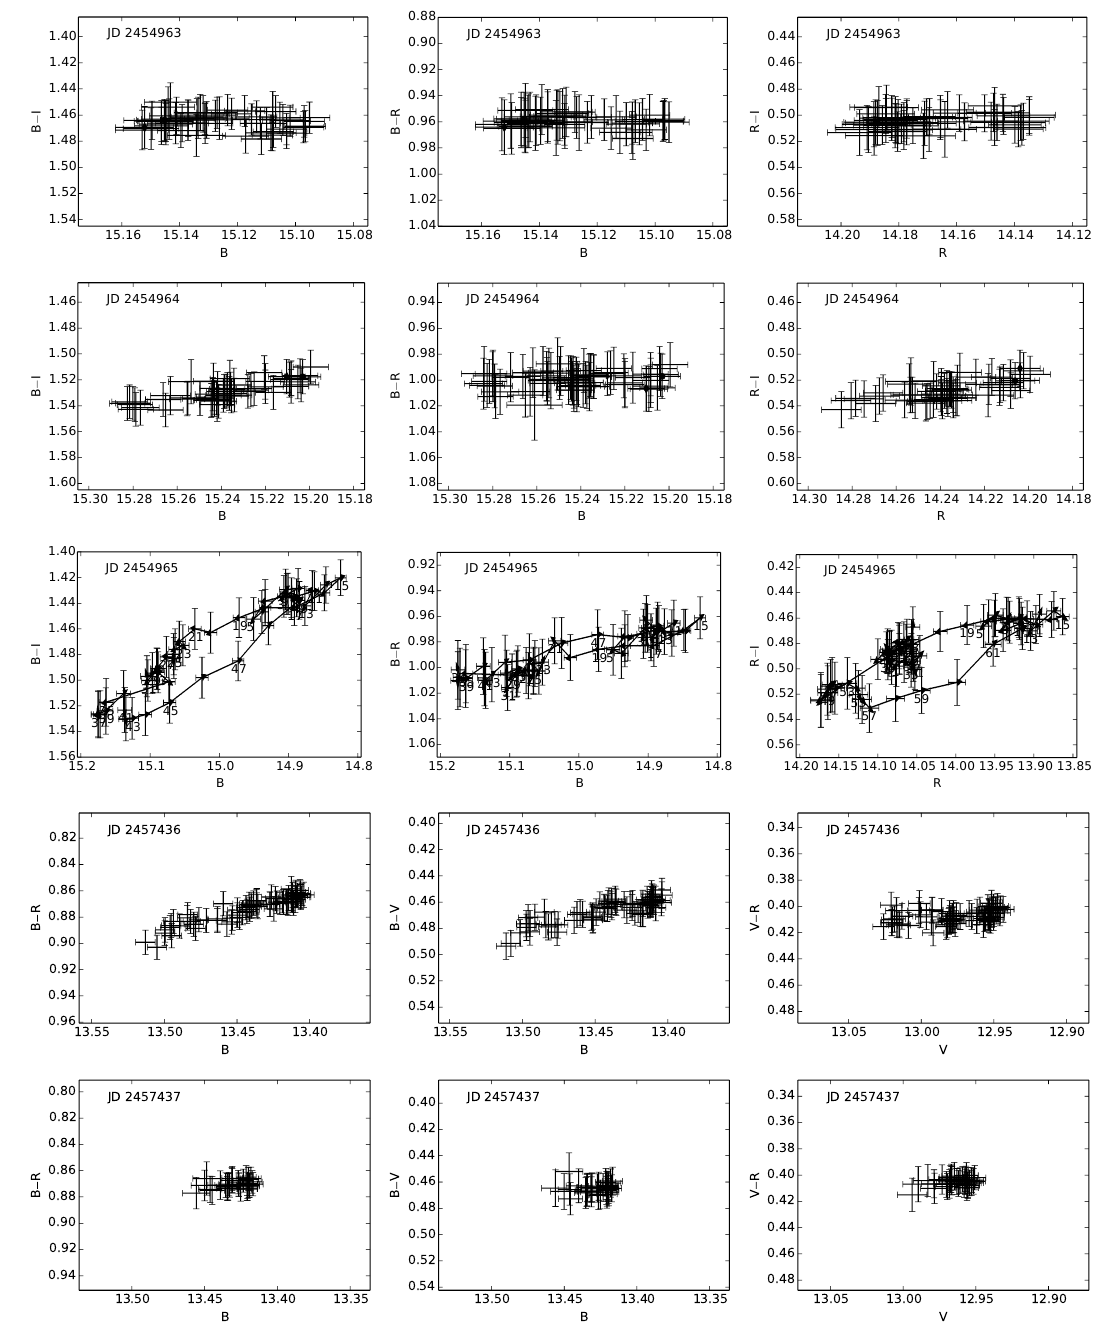
Figure 3. Color-magnitude diagrams of each separate